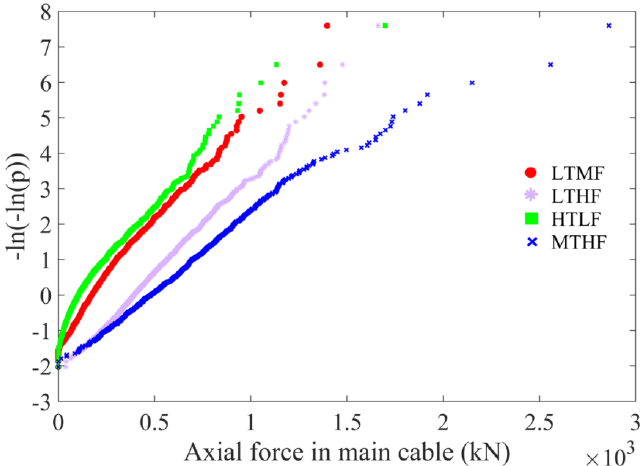
Figure 8. Probability paper plots of axial force in main cable for low trucks/medium flow (LTMF), low trucks/high flow (LTHF), high trucks/low flow (HTLF) and medium trucks/high flow (MTHF).